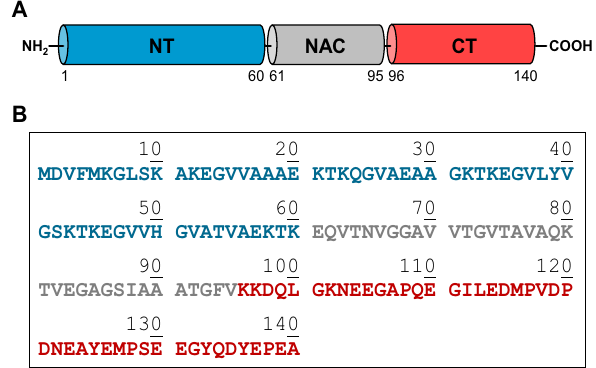
Figure 1. Domain architecture ( A ) and amino acid sequence ( B ) of human αSyn. NT: the N-Terminal domain region (amino acids 1–60) is positively charged (pI: 9.4) and assumes a helical conformation on lipid membrane surfaces. NAC: the Non-Amyloid α-Component (amino acids 61–95) is highly hydrophobic, has strong β-sheet conformational propensity, and mediates αSyn aggregation/fibrillation. CT: the C-Terminal domain (amino acids 96–140), is strongly negative (pI: